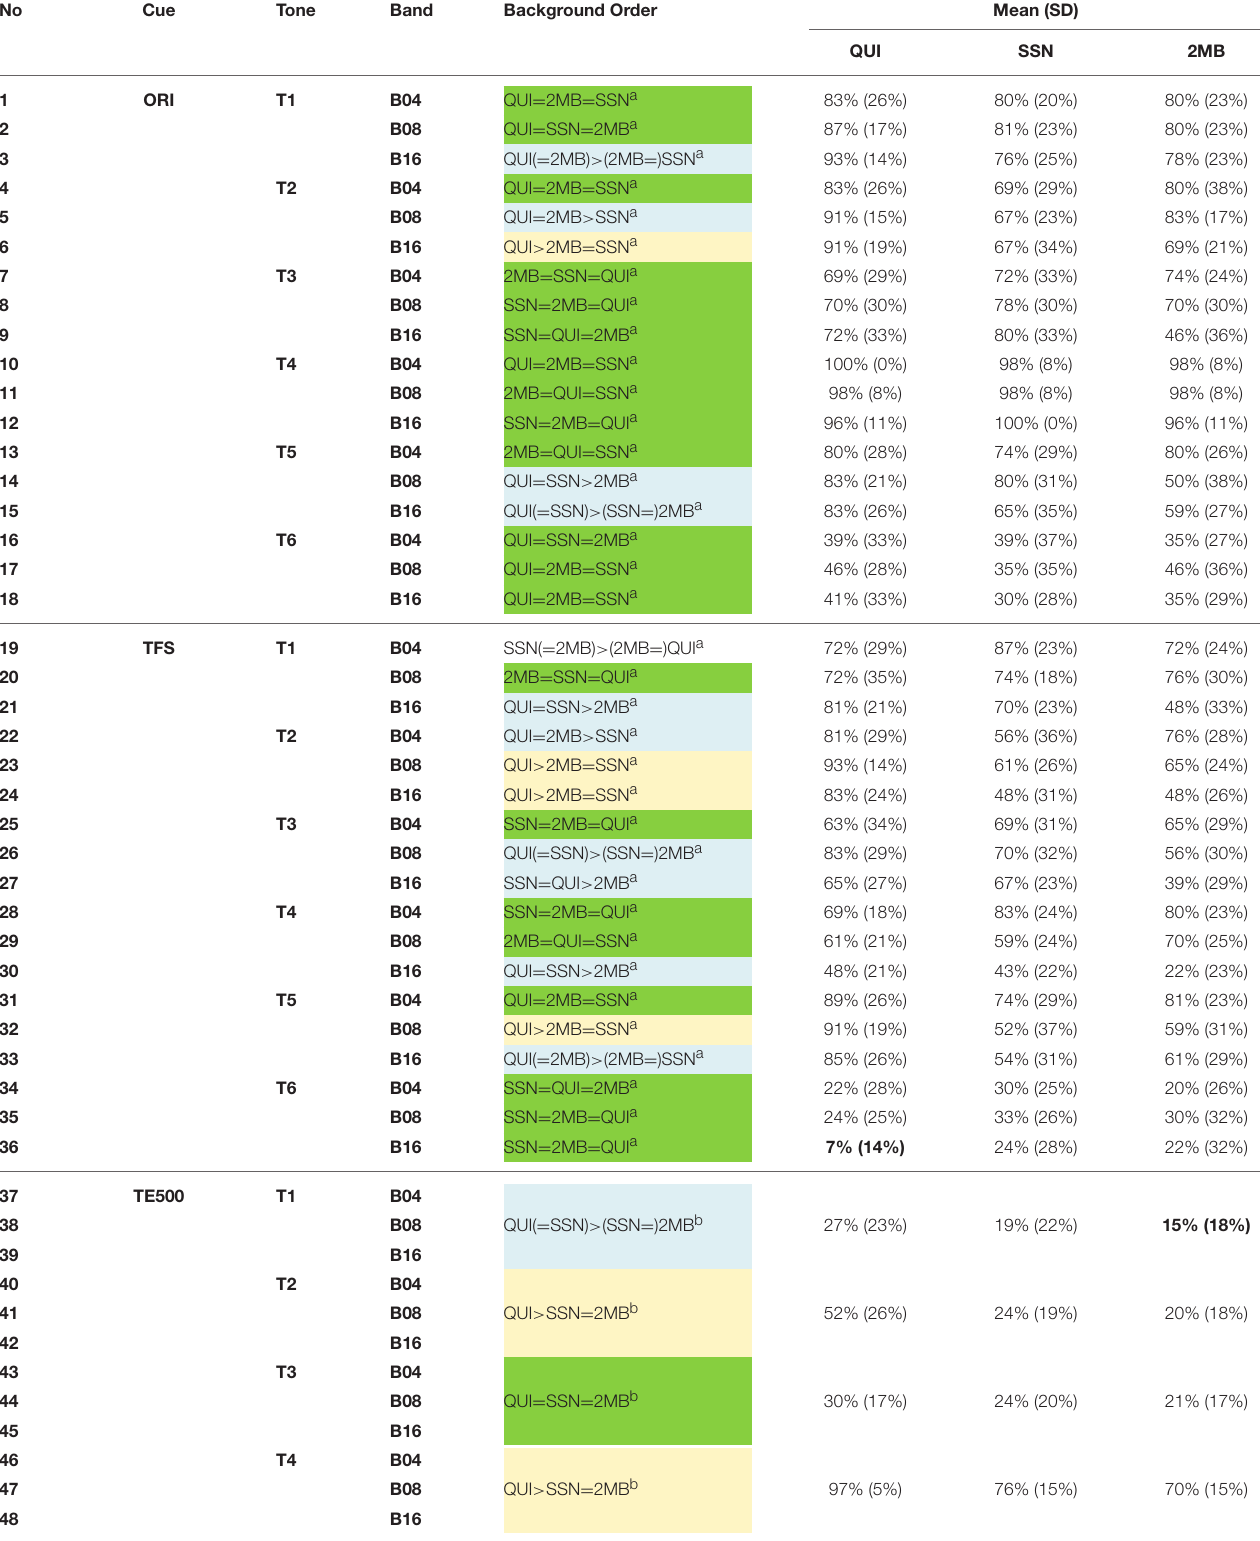
TABLE 11 | Results of pairwise comparisons in Tones * Bands * Backgrounds three-way repeated measures ANOVA on tone